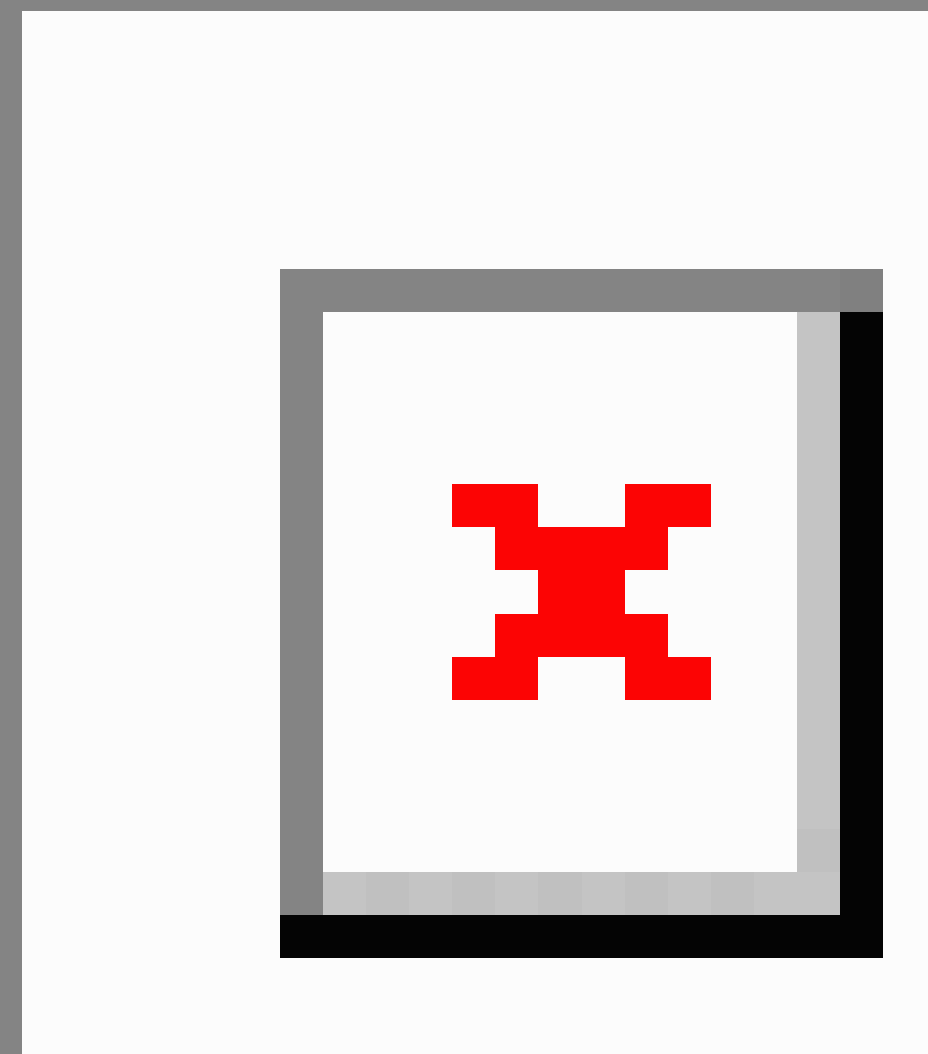
Figure 3. REMOTE-CR web-based app